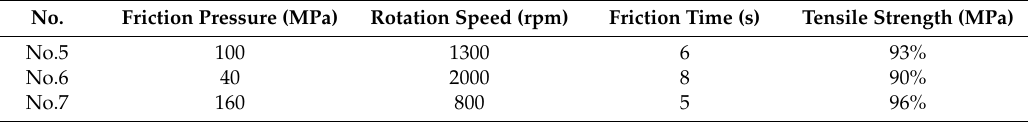
Figure 14. Variation trend of optimum energy-input with forging pressure. Table 3. Welding parameters and tensile strength of verification experiments.